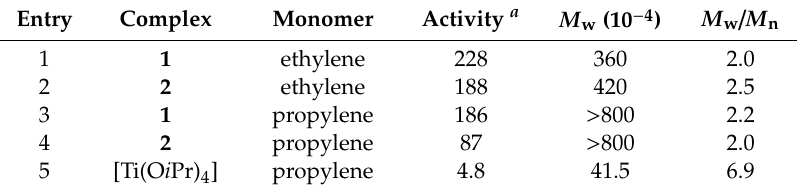
Scheme 1. Simplified mechanism for the Ti-catalyzed olefin polymerization. Table 1. Ethylene and propylene polymerization catalyzed by 1 and 2 / MAO systems